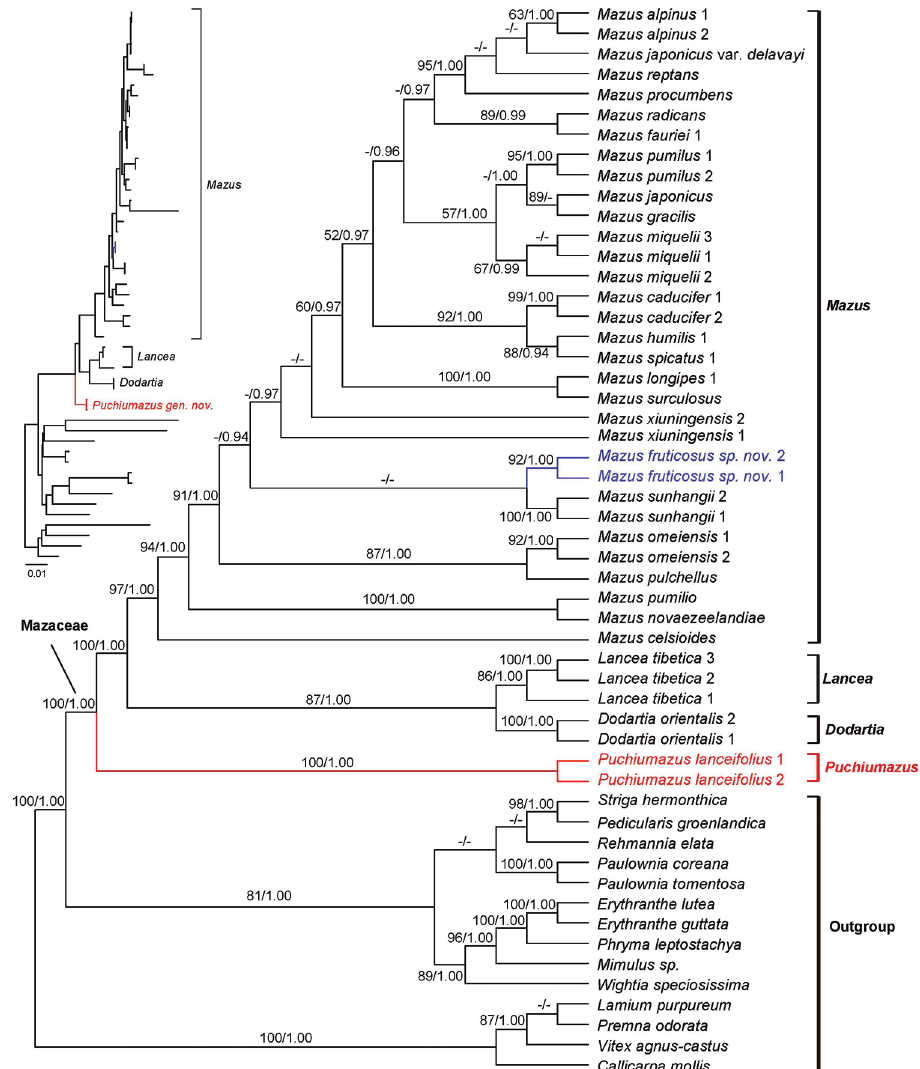
Figure 3. Maximum Likelihood phylogram of Mazaceae as inferred from analysis of combined dataset of matK , rbcL , rps16 and trnL - trnF . Support values ≥ 50% BS or 0.90 PP are displayed near the branches following the order